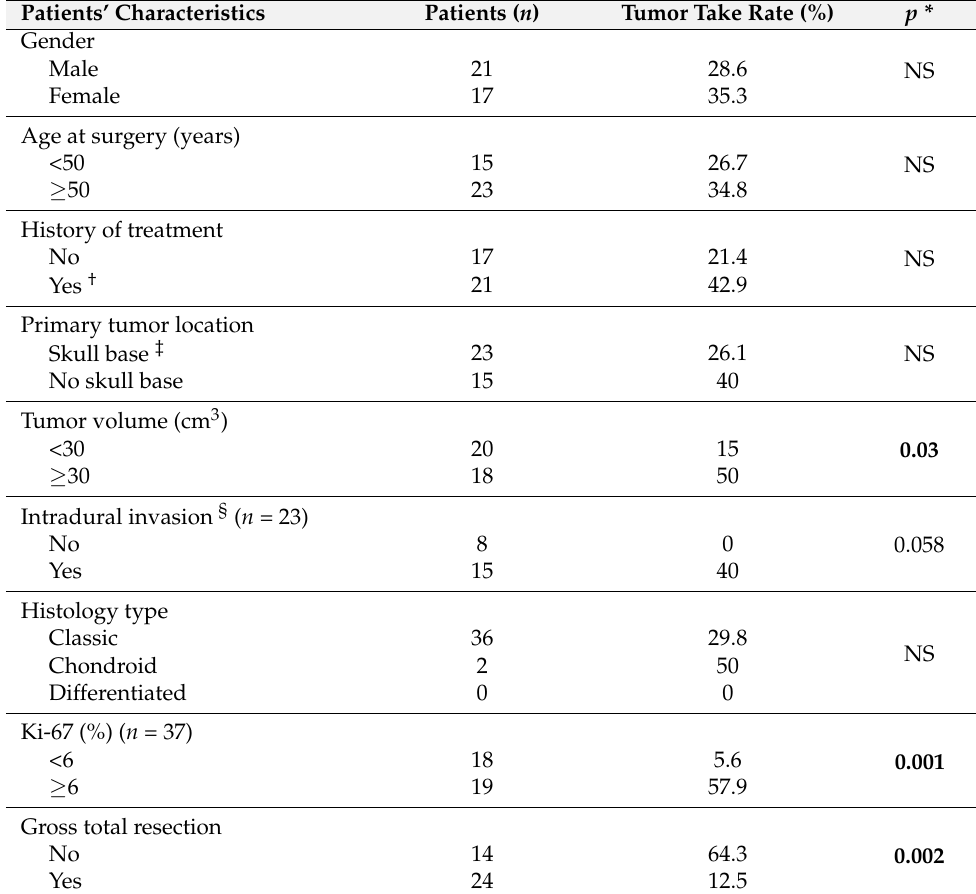
Table 1. Clinical and radiological characteristics of all chordoma patients ( n = 38; univariate analysis) and in vivo tumor take rate